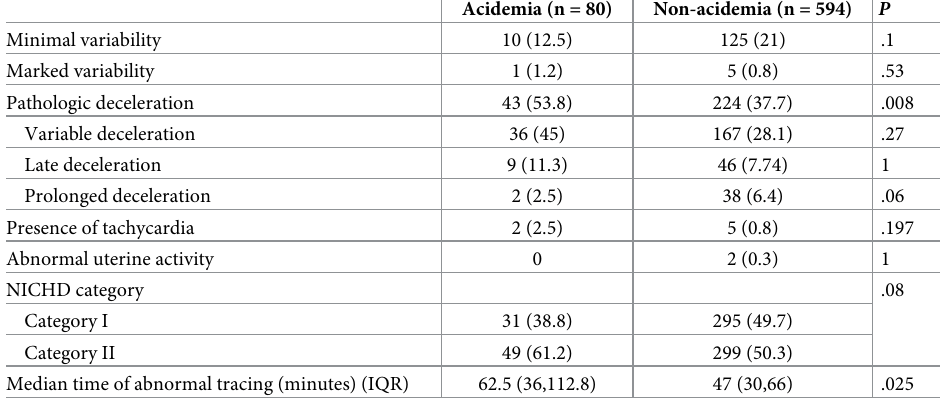
Table 2. EFM parameters according to the NICHD 3-tier interpretation system.